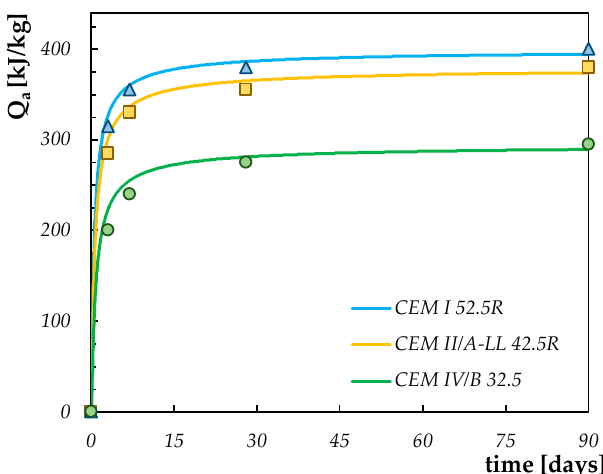
Figure 2. Calibration of hydration adiabatic curves for the cements considered in this study.